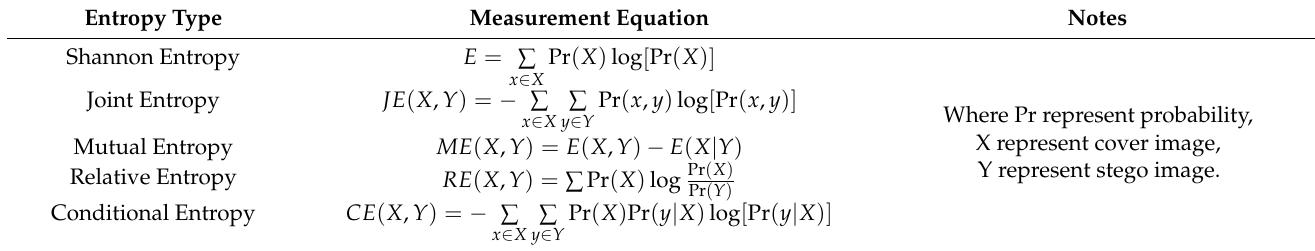
Table 3. Formulae for all entropy types.